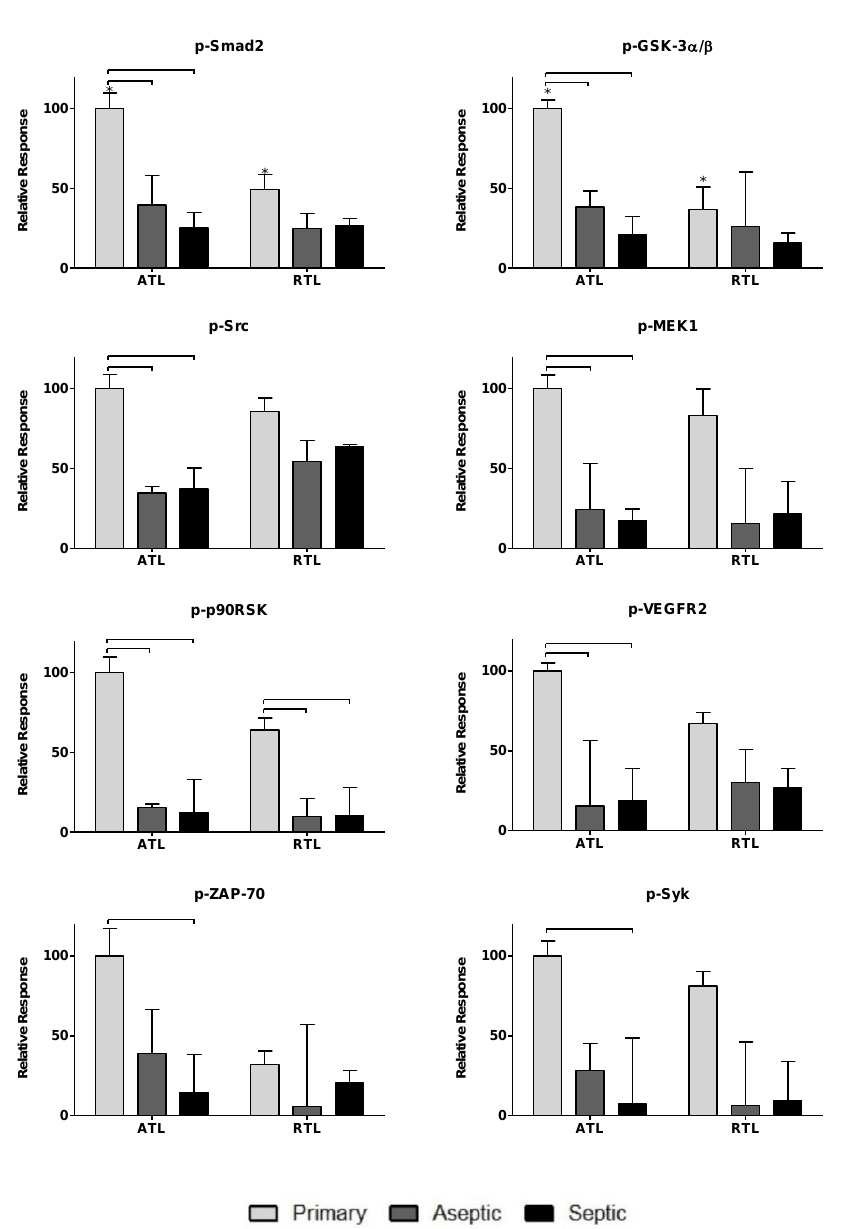
Figure 4. Relative phosphoprotein levels associated with cell migration processes in acute wound healing. Relative phosphoprotein responses (normalized to highest signal) were observed for all three patient groups: primary, aseptic, and septic at two debridement depths: ATL is closer to the knee joint, and RTL is approximately 1 cm removed from the knee joint. Statistically significant di ff erences ( p < 0.05) were determined by two-way ANOVA with Bonferroni’s post-test to examine group-dependent and spatially-dependent di ff erences in protein phosphorylation. Di ff erences for the same group (i.e., septic) between ATL and RTL are marked with an asterisk (*). Di ff erences between groups within a tissue layer are denoted with bars. Responses are shown as the mean ± SEM.